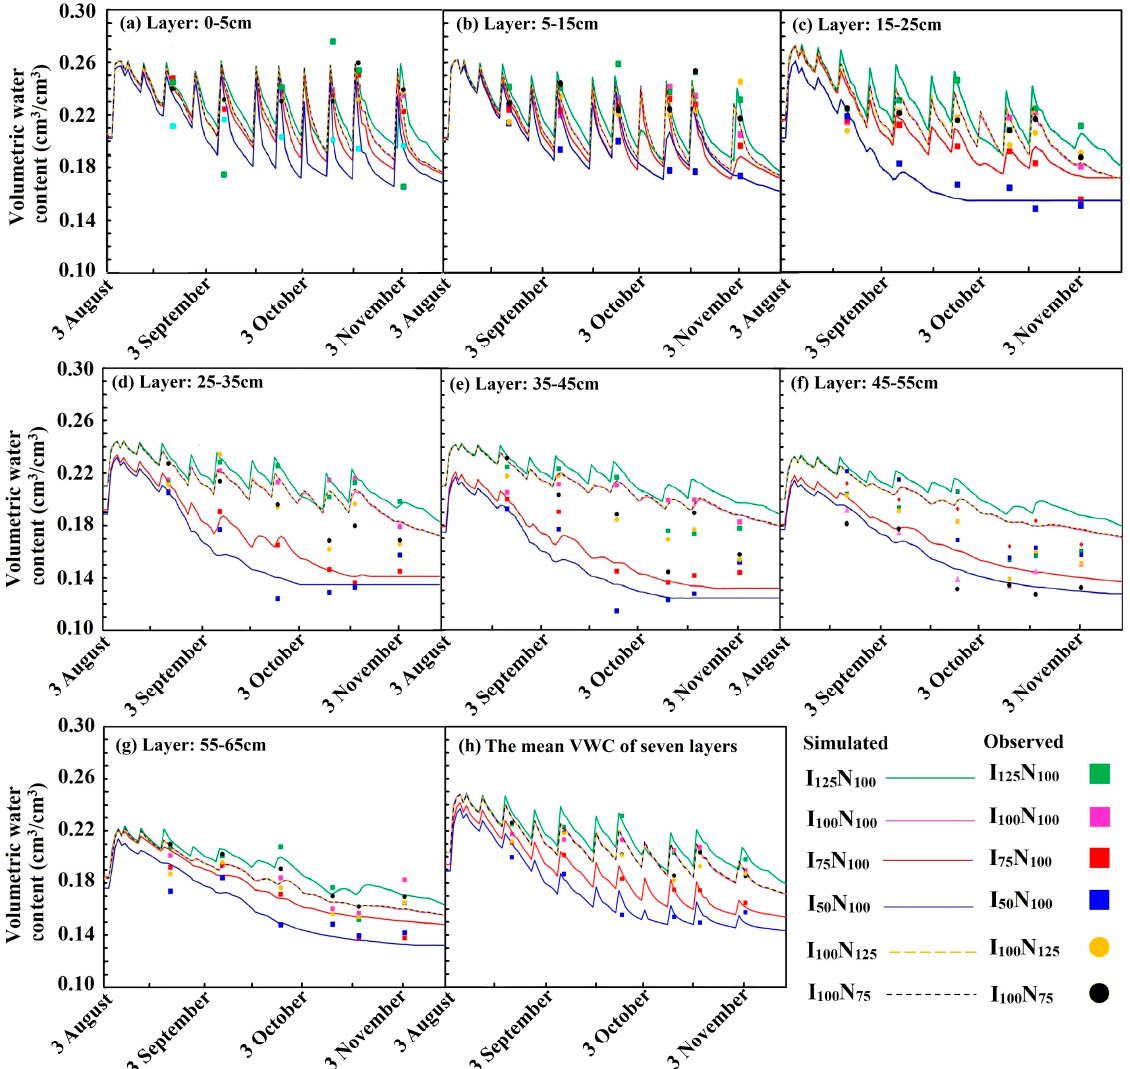
Figure 2. Observed and simulated soil volumetric water content (VWC, cm 3 /cm 3 ) for each SDF scenario at the depths of 0–5 ( a ), 5–15 ( b ), 15–25 ( c ), 25–35 ( d ), 35–45 ( e ), 45–55 ( f ), 55–65 cm ( g ) and the mean values of the seven layers (h). The I 100 N 100 scenario was the calibration phase. The remaining five scenarios (i.e., I 125 N 100 , I 75 N 100 , I 50 N 100 , I 100 N 125 and I 100 N 75 ) were the validation phase. Other notations used in this table are the same as those in Table